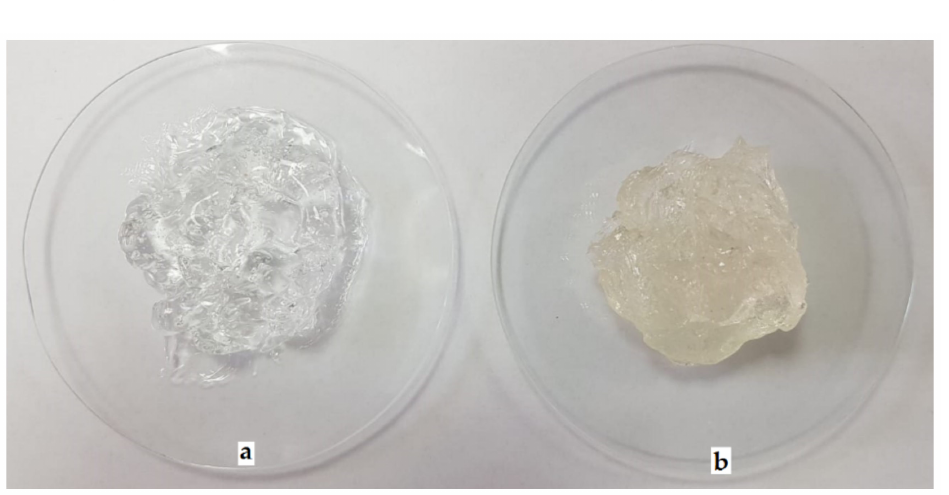
Figure 2. Macroscopic appearance of the experimental poloxamer binary hydrogels: ( a ) B-PbH and ( b )